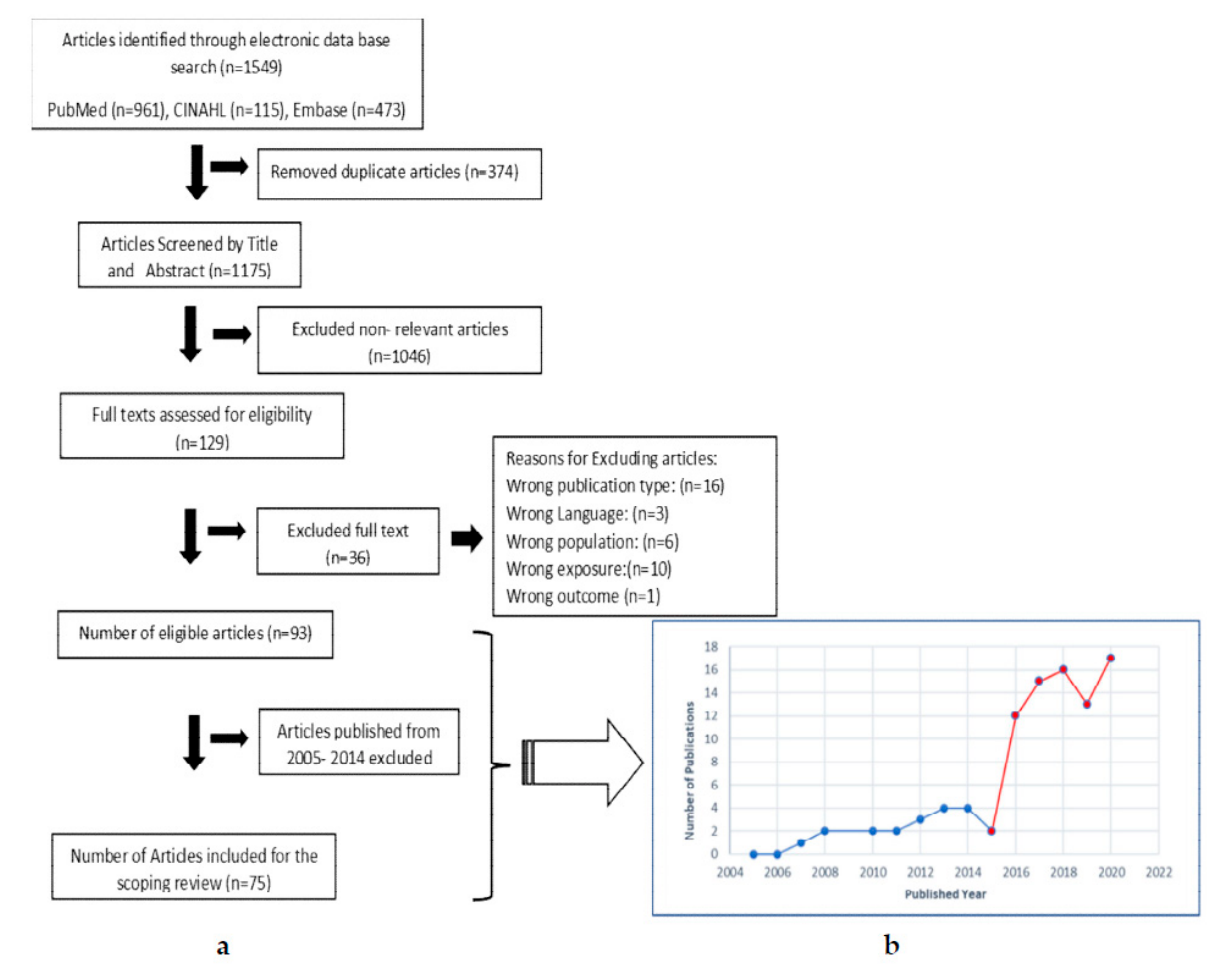
Figure 1. Article selection process. ( a ) Flow chart of article selection process. ( b ) Number of publi-